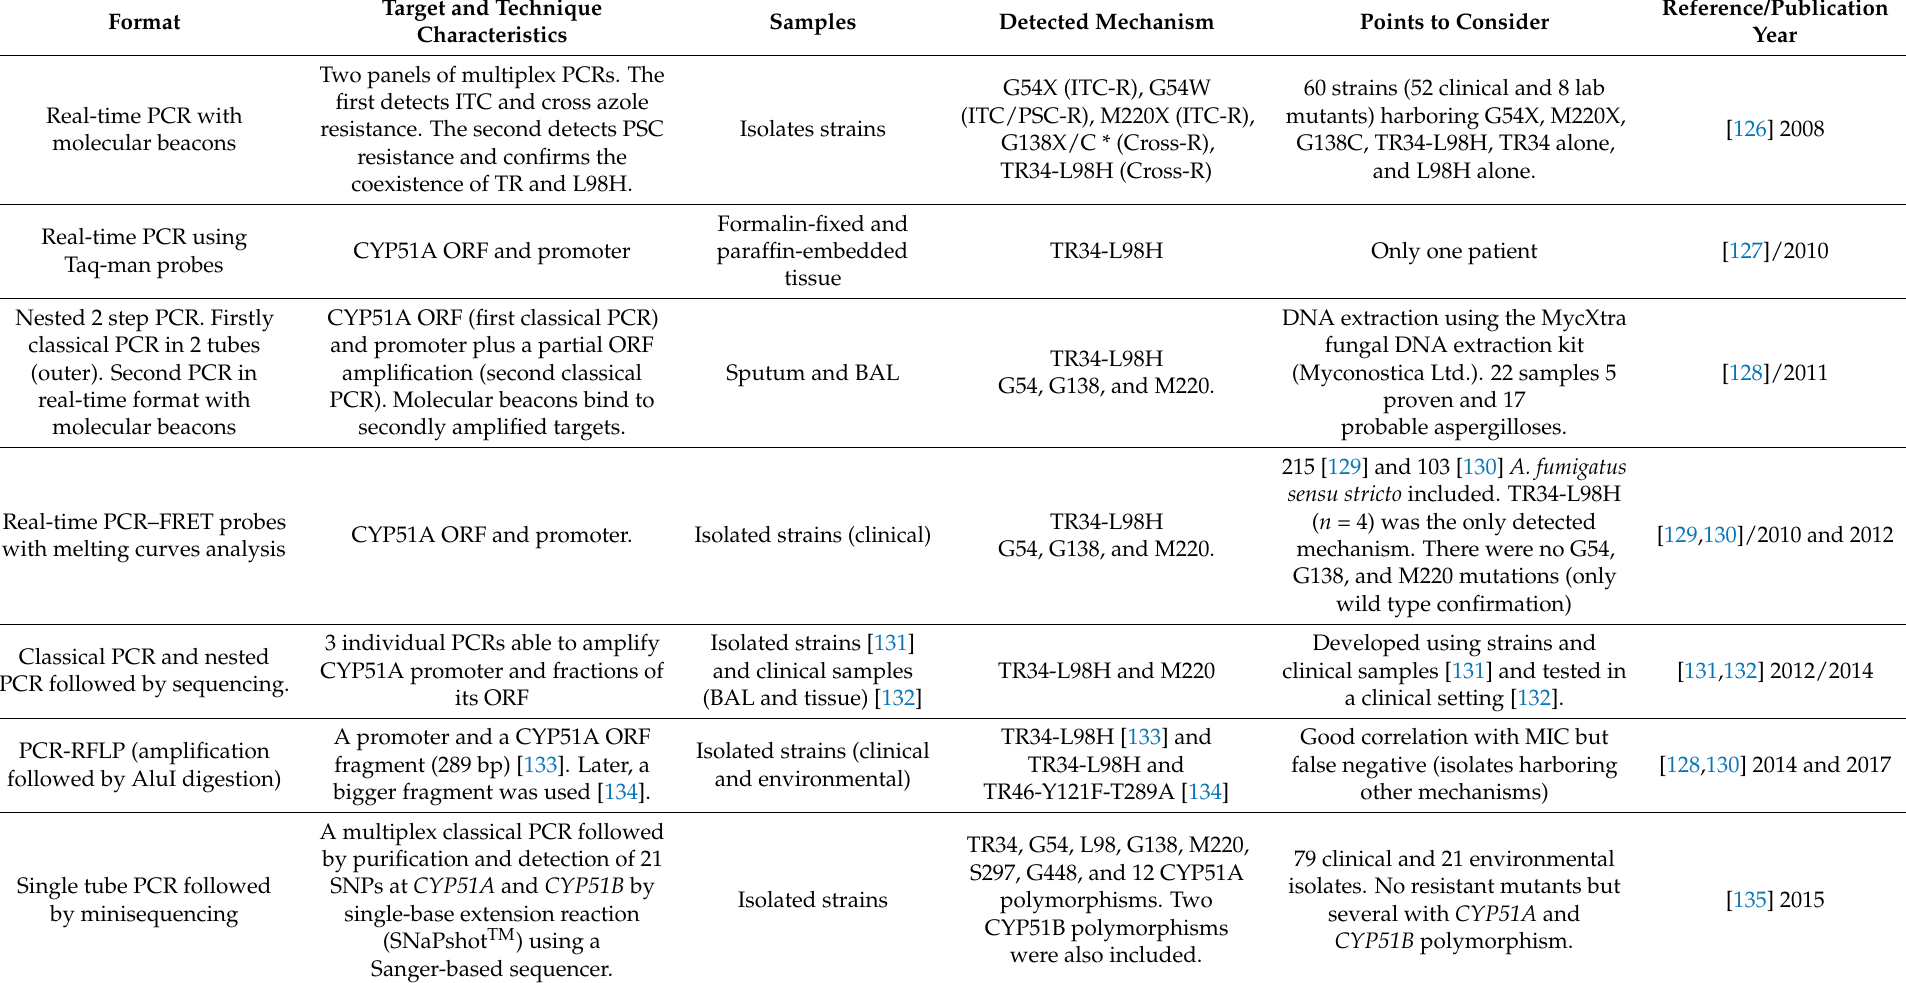
Table 1. Molecular tools for the detection of mechanisms of triazole resistance in Aspergillus